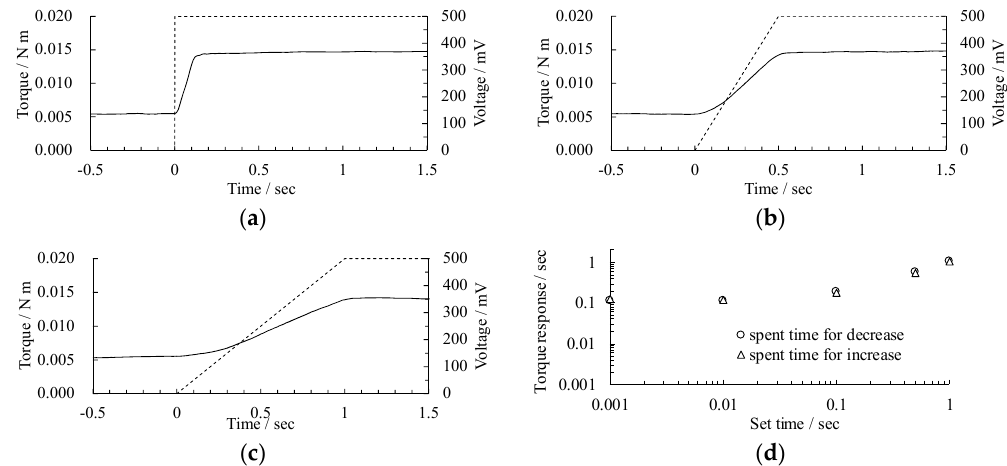
Figure 5. Response ability of the device. ( a – c ) Changes in the torque (solid lines) and in the voltage (dotted lines). ( d ) Relation between the increasing/decreasing time of the voltage and the response time of the torque.